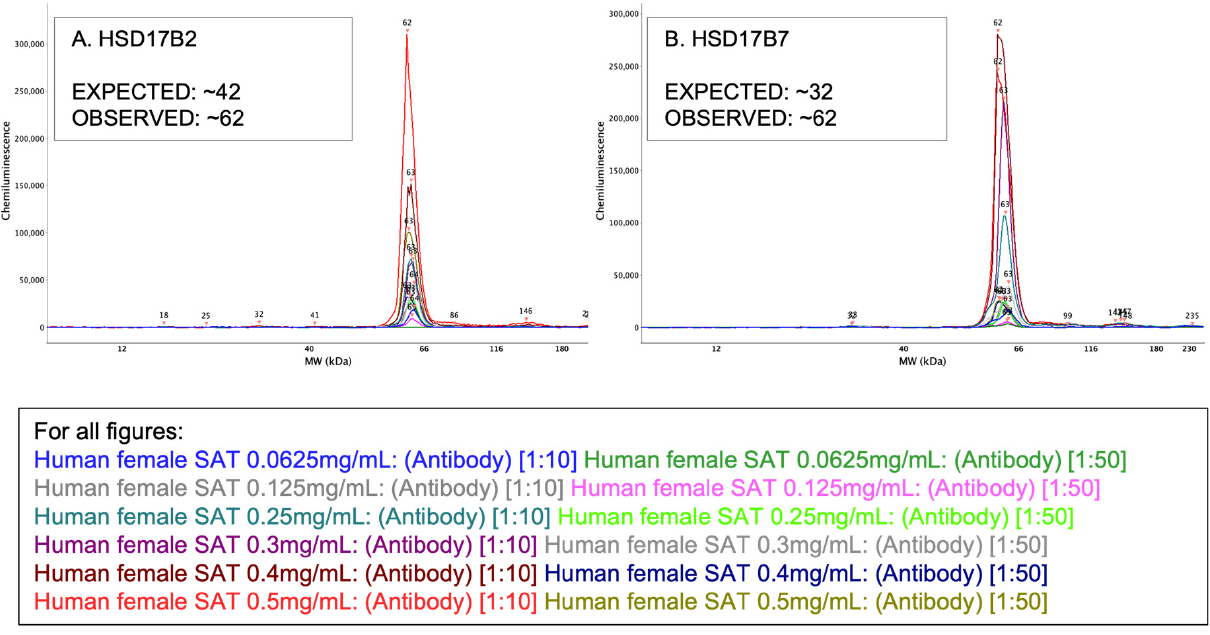
Figure 4. Protein quantification in reduced lysate concentrations (0.0625, 0.125, 0.25, 0.3, 0.4, and 0.5 mg/mL) paired with identical antibody concentrations (1:10 and 1:50) for ( A ) HSD17ß2 and ( B )